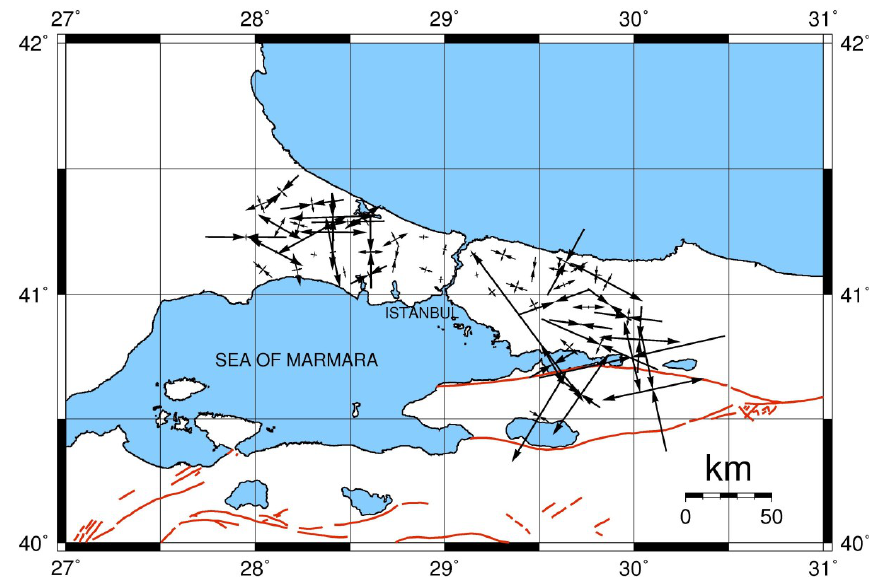
Fig. 3. Principal strain parameters of the